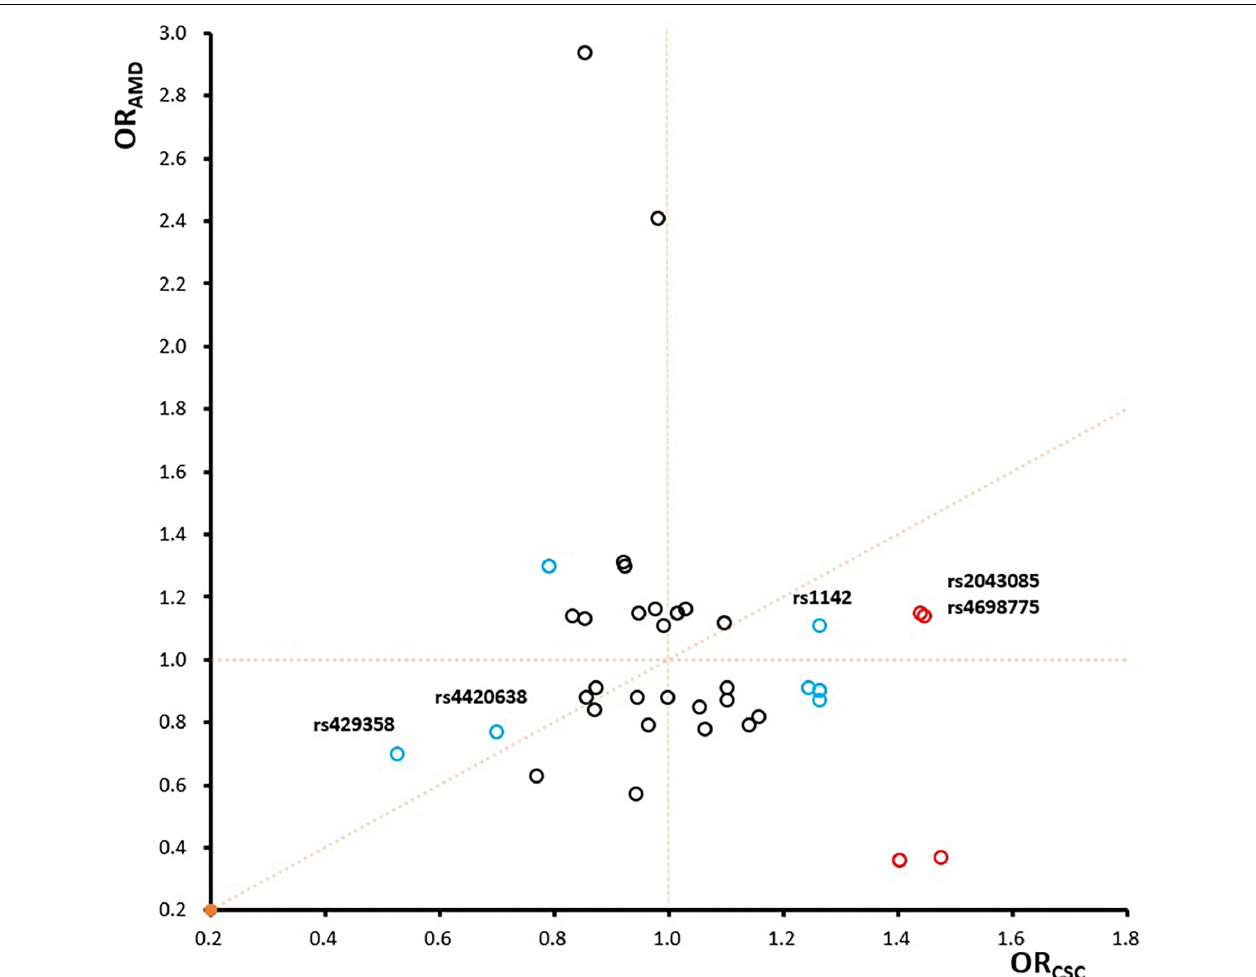
FIGURE 4 | The comparison of odds ratios between CSC and AMD. The four significant SNPs are labeled in red, other eight SNPs with achieved nominal association significance ( p < 0.05) are labeled in blue, and the remaining ones are in